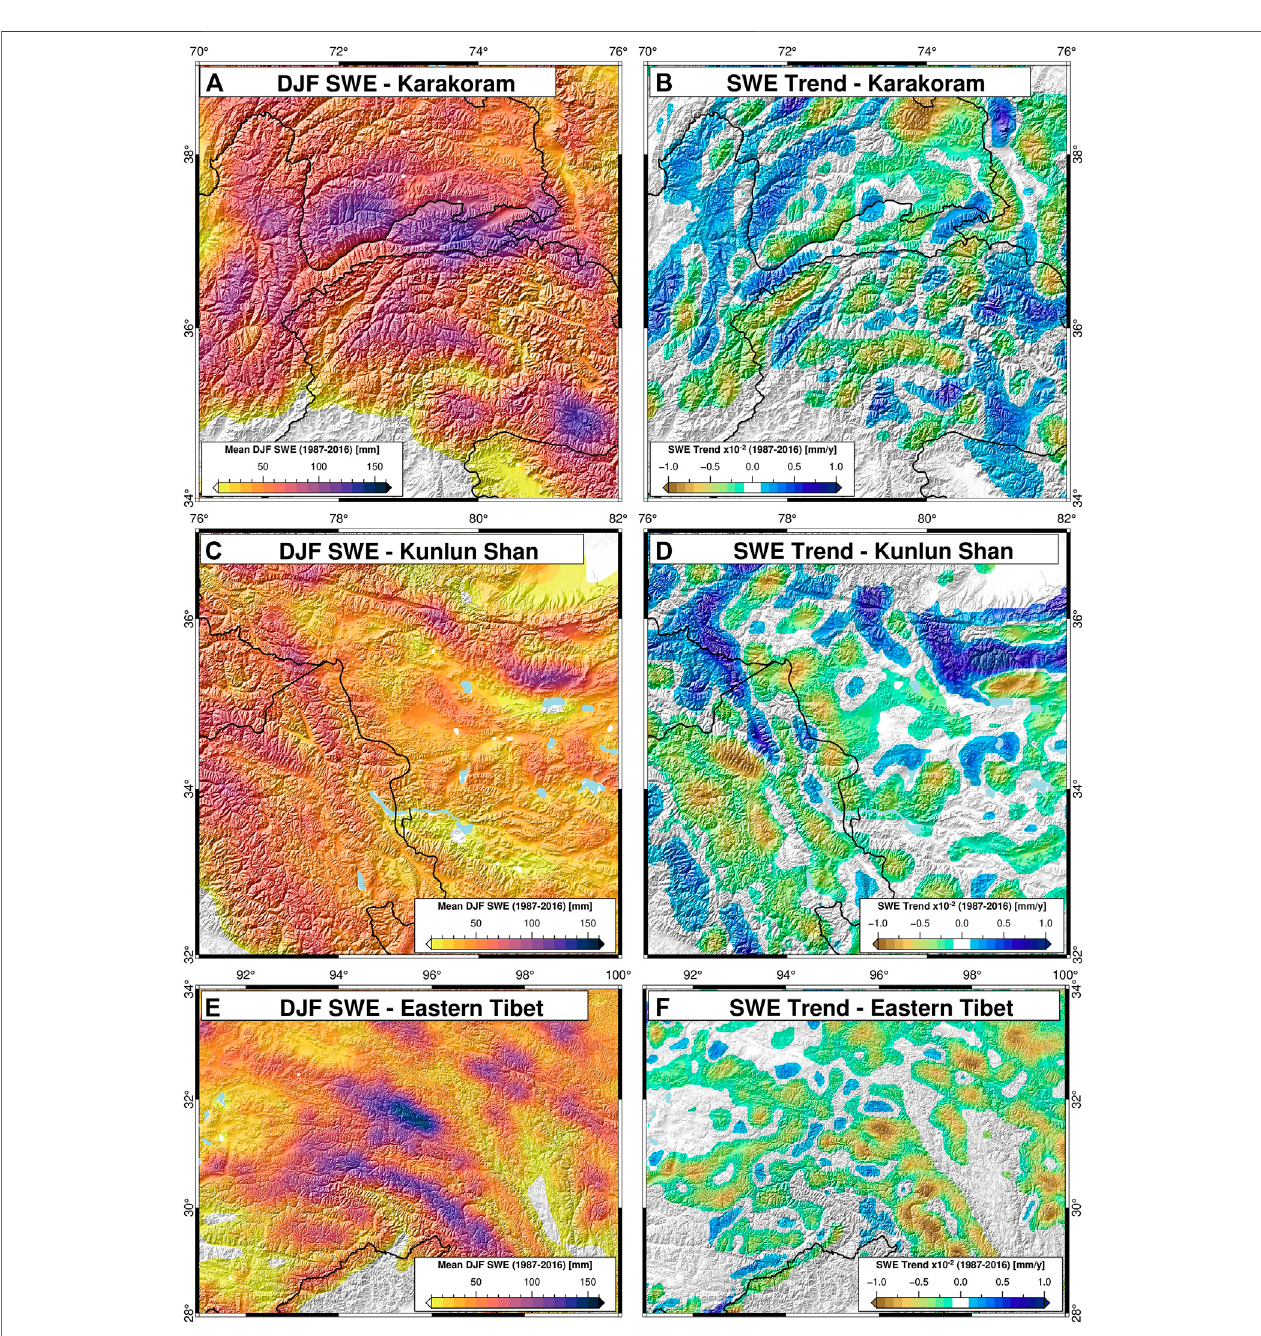
FIGURE 4 | Regional zoom maps (see Figure 1 for locations). Average December-January-February (DJF) snow-water equivalent (SWE) (left column) and annual SWE trends (1987 – 2016, right column) for the (A,B) Karakoram-Pamir, (C,D) Kunlun Shan, and (E,F) Eastern Tibetan regions. Regional SWE trends show clear differences in magnitudes and directions: high SWE areas in the (A) Karakoram and Pamir Mountains have a wide range of trends, but overall more negative trends in high SWE areas. The (B) Kunlun Shan has lower average SWE, but stronger positive trends. (E) Eastern Tibet has high SWE with overall strongly negative SWE